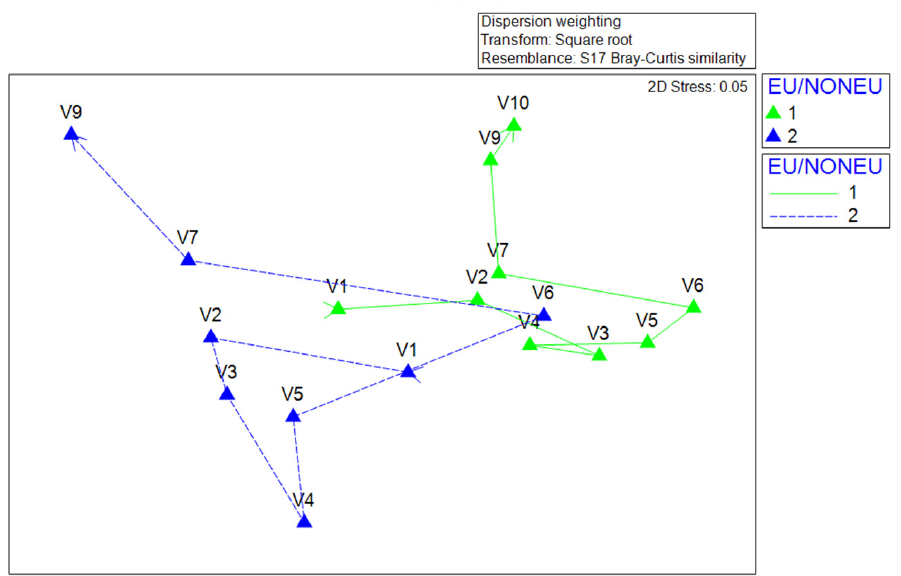
Figure 5. Non-metric multidimensional scaling (NMDS) ordination based on the Bray–Curtis similarity distance in the taxonomic composition of phytoplankton community on sampling stations (V1 to V10, excluding station V8) in Lake Visovac during August 2018 according to morphological approach. 1-EU-euphotic zone samples, 2-NONEU- aphotic zone samples.